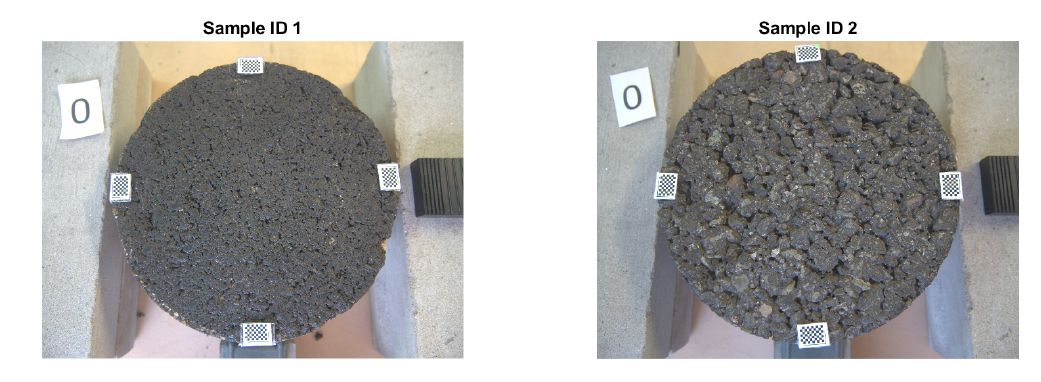
Figure 1. Samples. Left: Sample ID 1—Dense Graded. Right: Sample ID 2—Gap Graded.